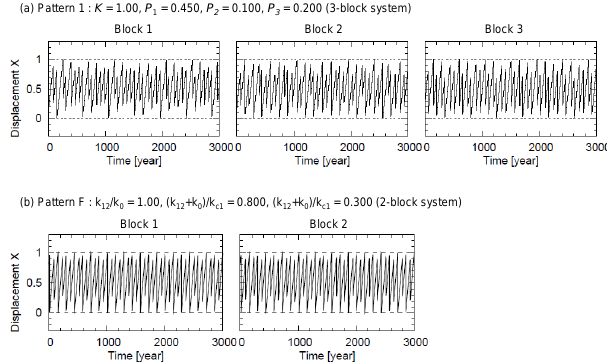
Figure 18. Example histories of the normalized displacement X of the three blocks from the reference point for (a) pattern 1 in the three-block system and (b) pattern F in the two-block system (Pa- per 1). The model parameters for pattern 1 are the same as those relating to Fig. 6. The upper and lower broken lines indicate the time- and slip-predictable models,